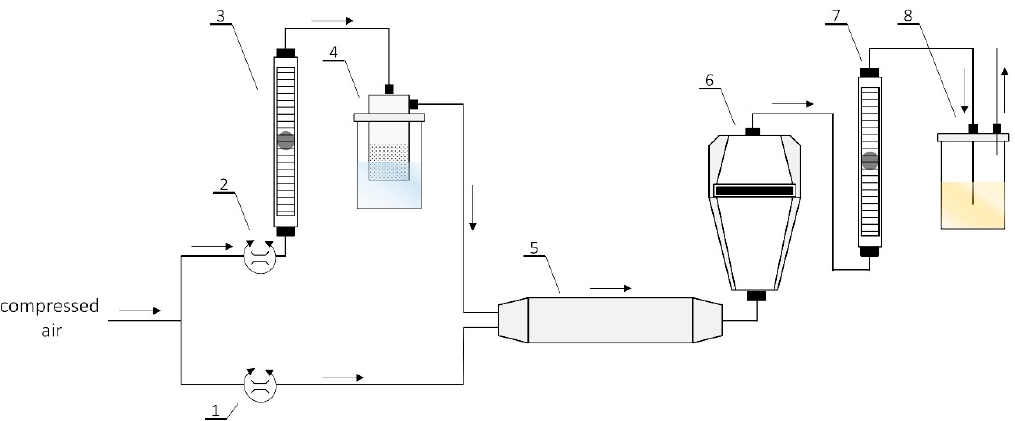
Figure 4. The scheme of the set-up used for the studies of efficiency and biocidal effectiveness of nonwovens: ( 1 , 2 ) Valves for precise air flow regulation compressor; ( 3 , 7 ) air flow meter; ( 4 ) collison atomizer; ( 5 ) in-line desiccator; ( 6 ) test chamber; and ( 8 ) outlet of bioaerosol.